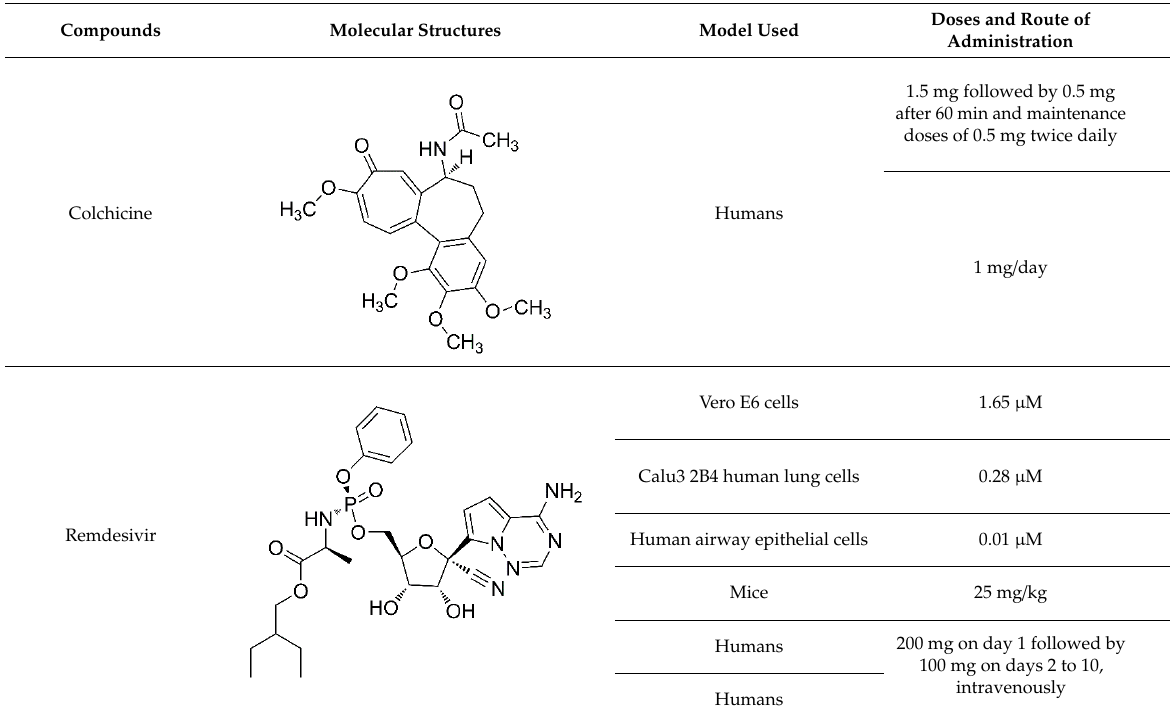
Table 2. Compounds of synthetic origin with anti-SARS-CoV-2 activity.